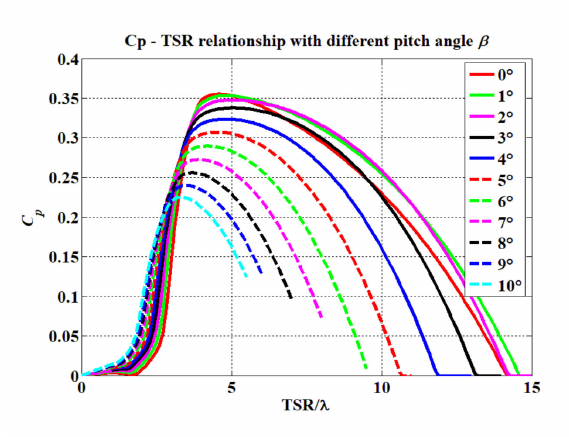
Figure 2. C p -TSR / λ curve with di ff erent pitch angles β